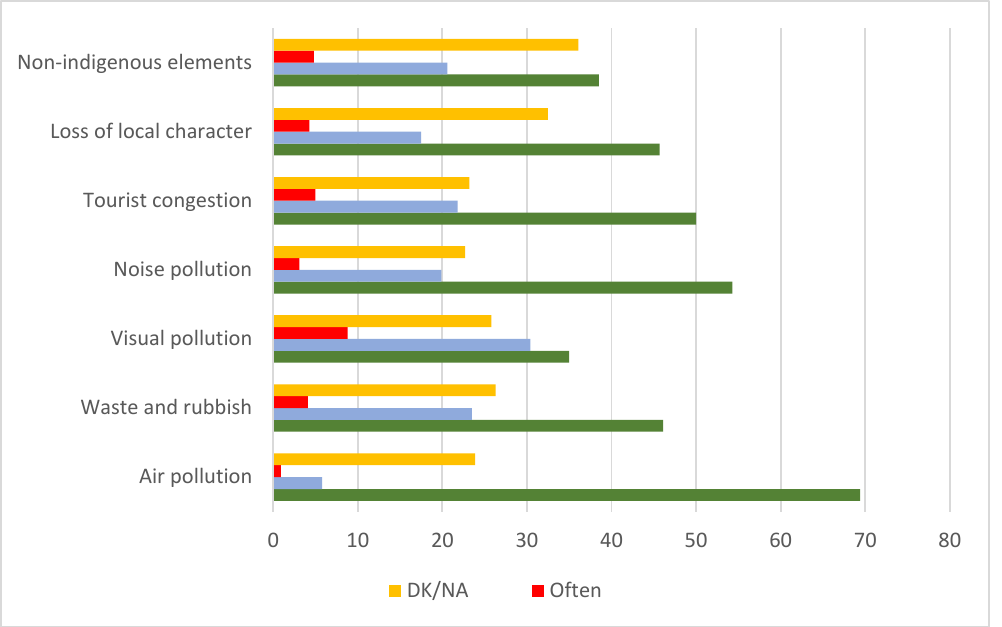
Figure 3. Landscape quality parameters detected (% survey) (Source: Own preparation).